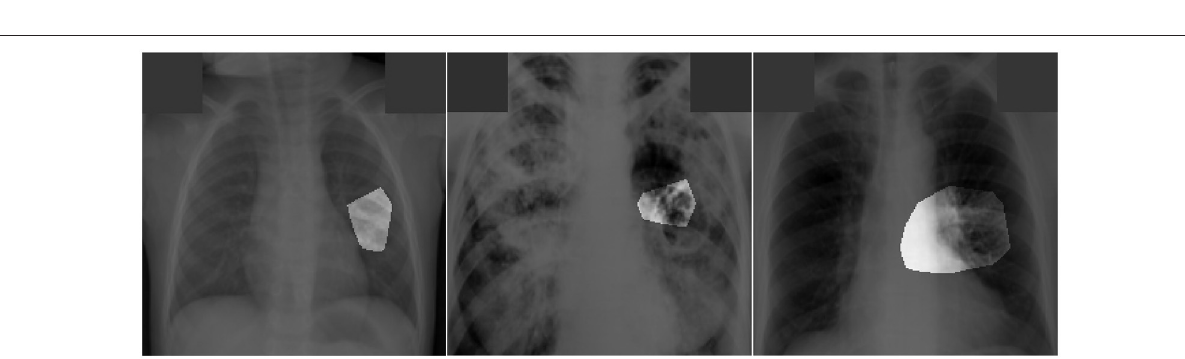
FIGURE 5 | Examples of patient cases with associated critical factors (highlighted regions) as identified by GSInquire (Lin et al., 2019) during explainability-driven performance validation. From left to right : (a) Case 1, (b) Case 2, and (c) Case 3. Radiologist validation showed that several of the critical factors identified are consistent with radiologist